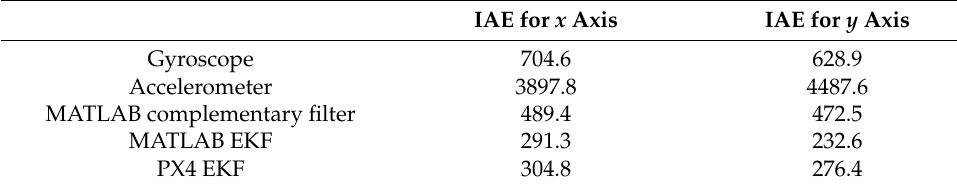
Table 1. Quality indicator.